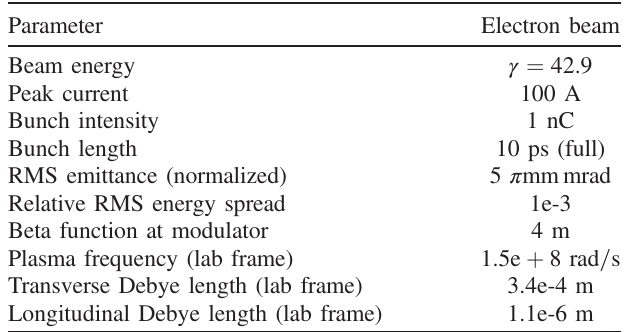
TABLE II. Parameters of electron